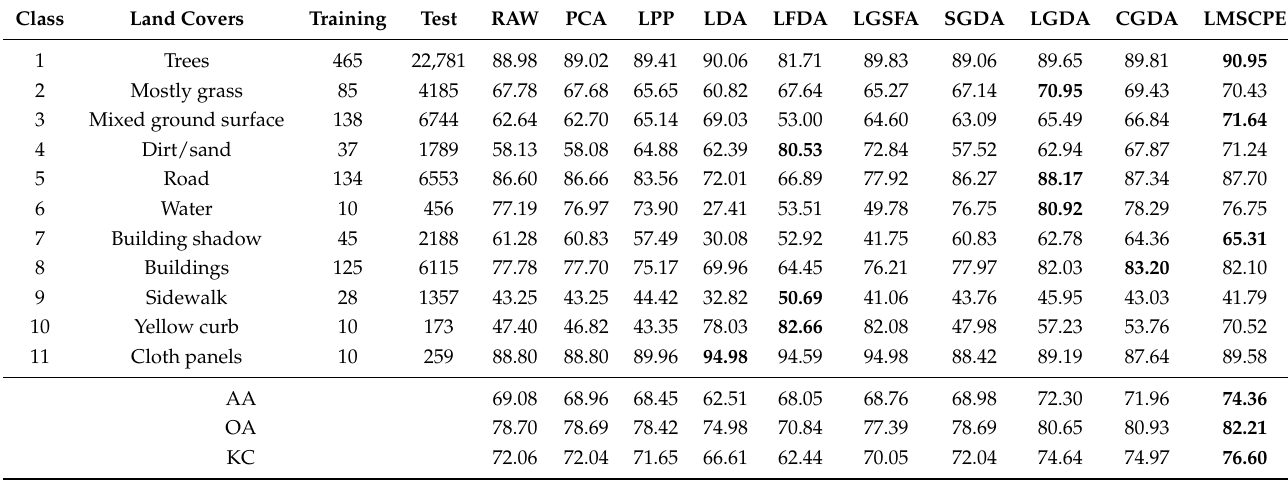
Table 6. Classification results (%) of each type of land covers (t = 1%) with the NN classifier on the MUUFL data set. (AA—average classification accuracy, OA—overall classification accuracy, KC—kappa coefficient, and the best results of a row are marked in bold).